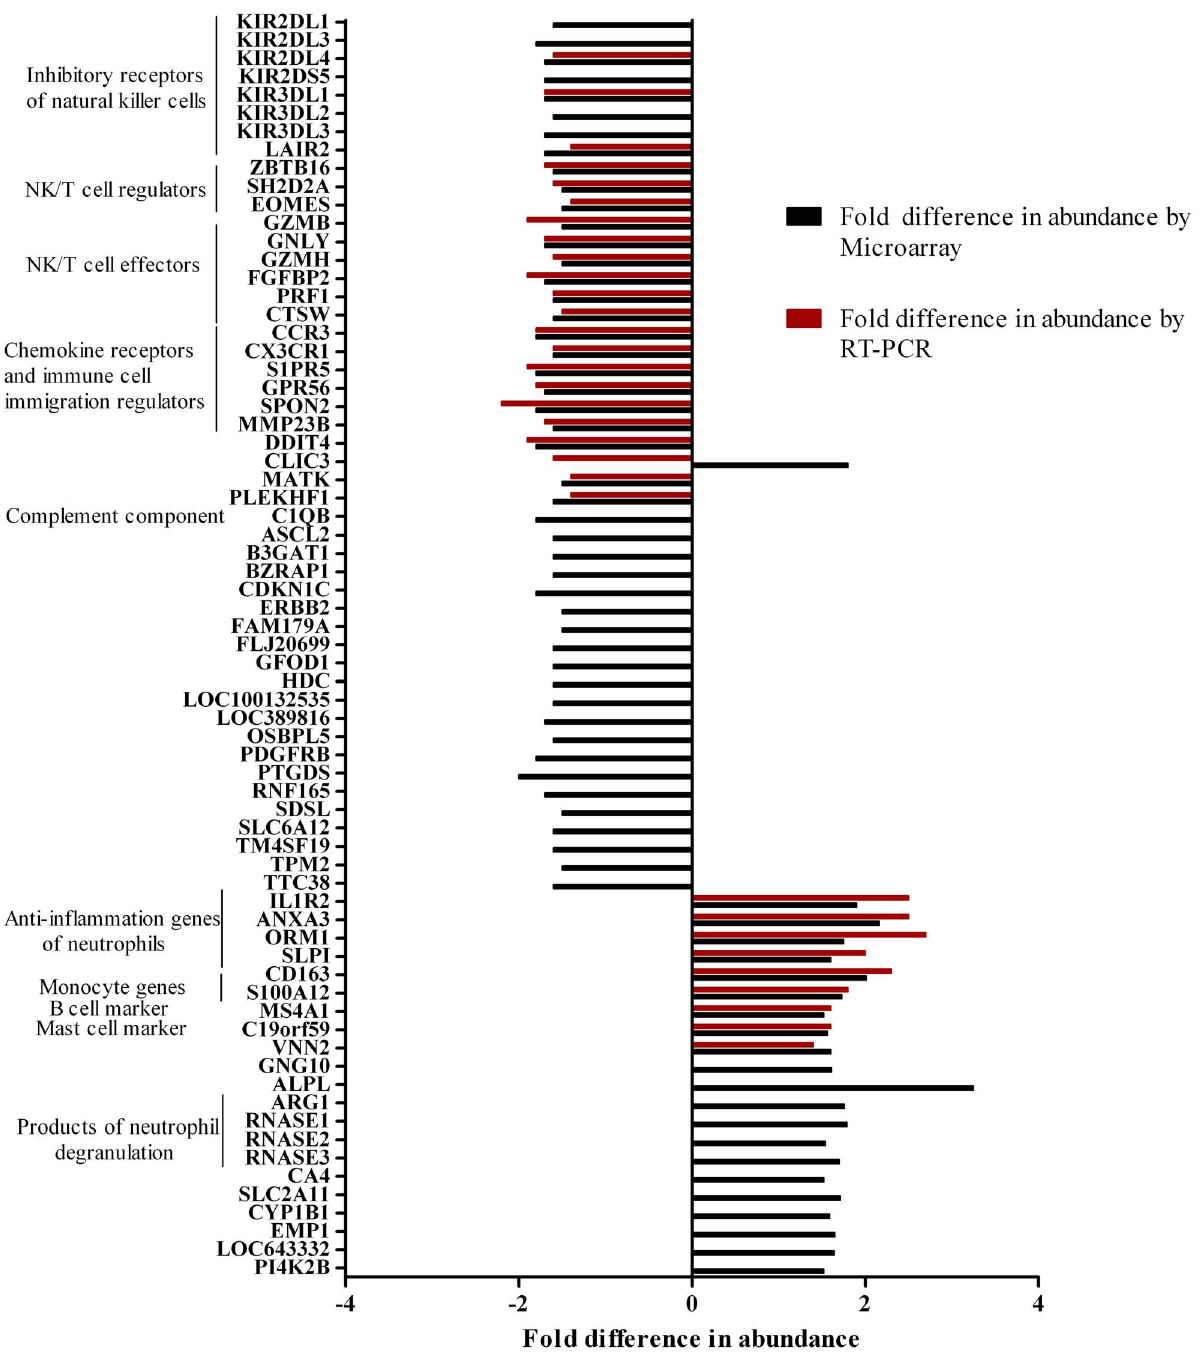
Figure 1. Fold difference in transcript abundance between high-dose prednisolone and placebo treated patients 2 days post initiation of treatment. Shown is the ratio in abundance of transcripts measured by microarray and by RT-PCR for the 67 genes that distinguished high-dose prednisolone treated patients from placebo treated patients. Where results from multiple probes in the microarray were available for 1 gene, we used the mean result. Genes have been grouped and annotated according to their recognized biological functions. Median (IQR) times from a) the start of treatment and b) the most recent dose, to the time of the microarray sample were similar; 43 (42–43) hours and 23 (22–24) hours for the high-dose prednisolone recipients, and 43 (42–44) hours and 22 (22–23) hours for the placebo recipients.